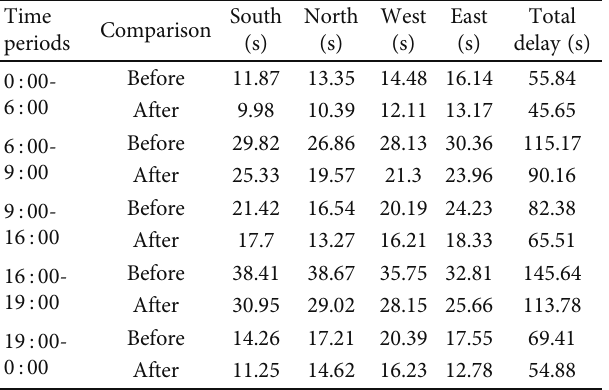
Table 6: Simulation result before and after optimization.